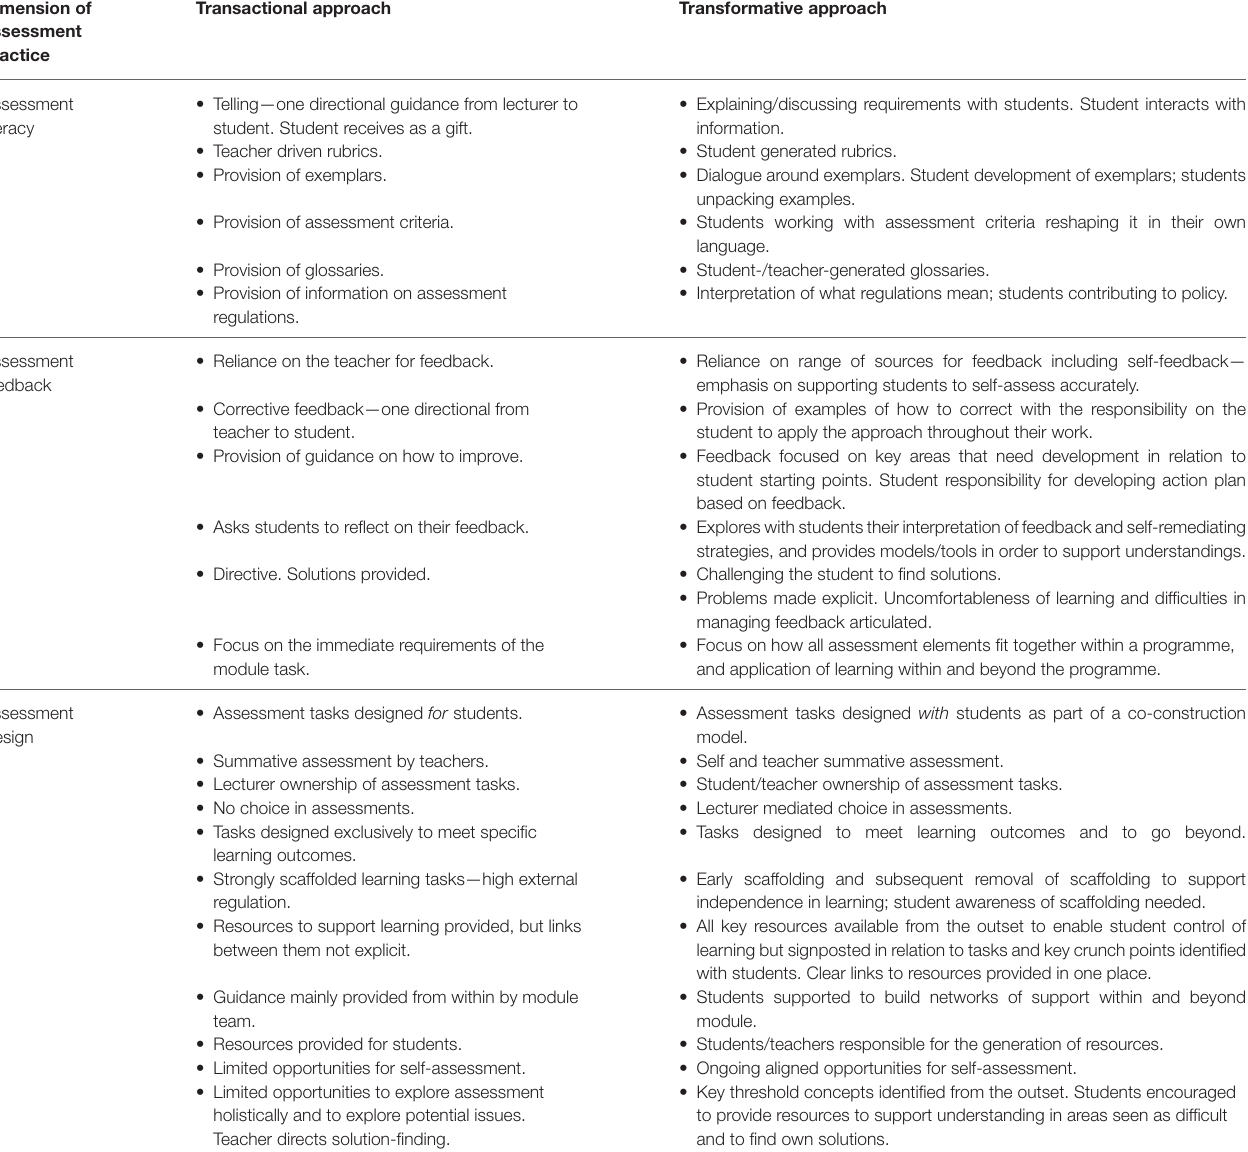
TABLE 1 | Evans (2018) Transformative approaches to assessment practices using the EAT Framework compared to transactional approaches. Dimension of